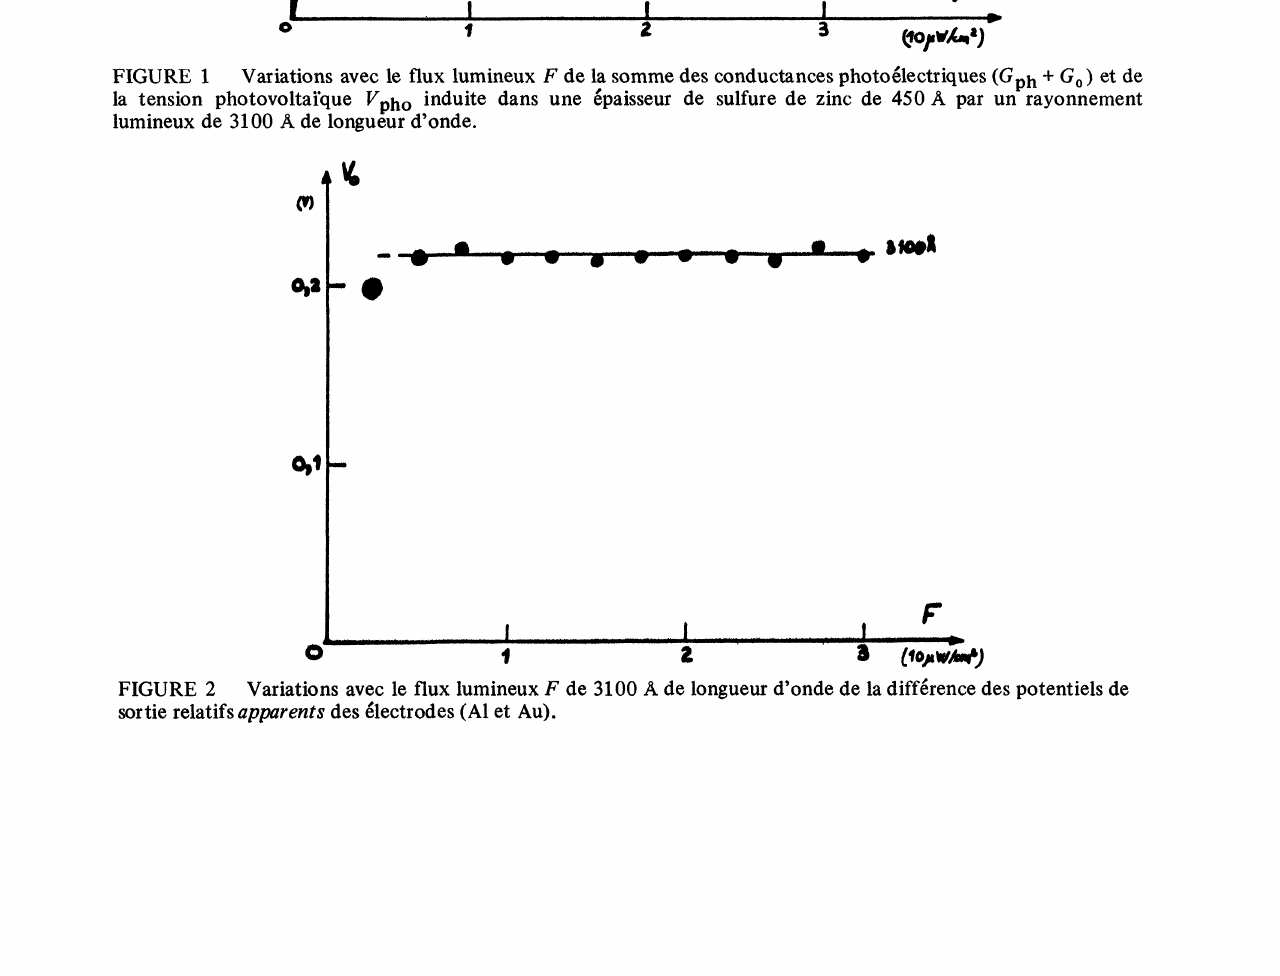
FIGURE 1 Variations avec le flux lumineux F de la somme des conductances photolectriques (Gph + Go) et de la tension photovoltai’que Vph o induite dans une paisseur de sulfure de zinc de 450 A par un rayonnement lumineux de 3100 A de longu6ur d’onde.